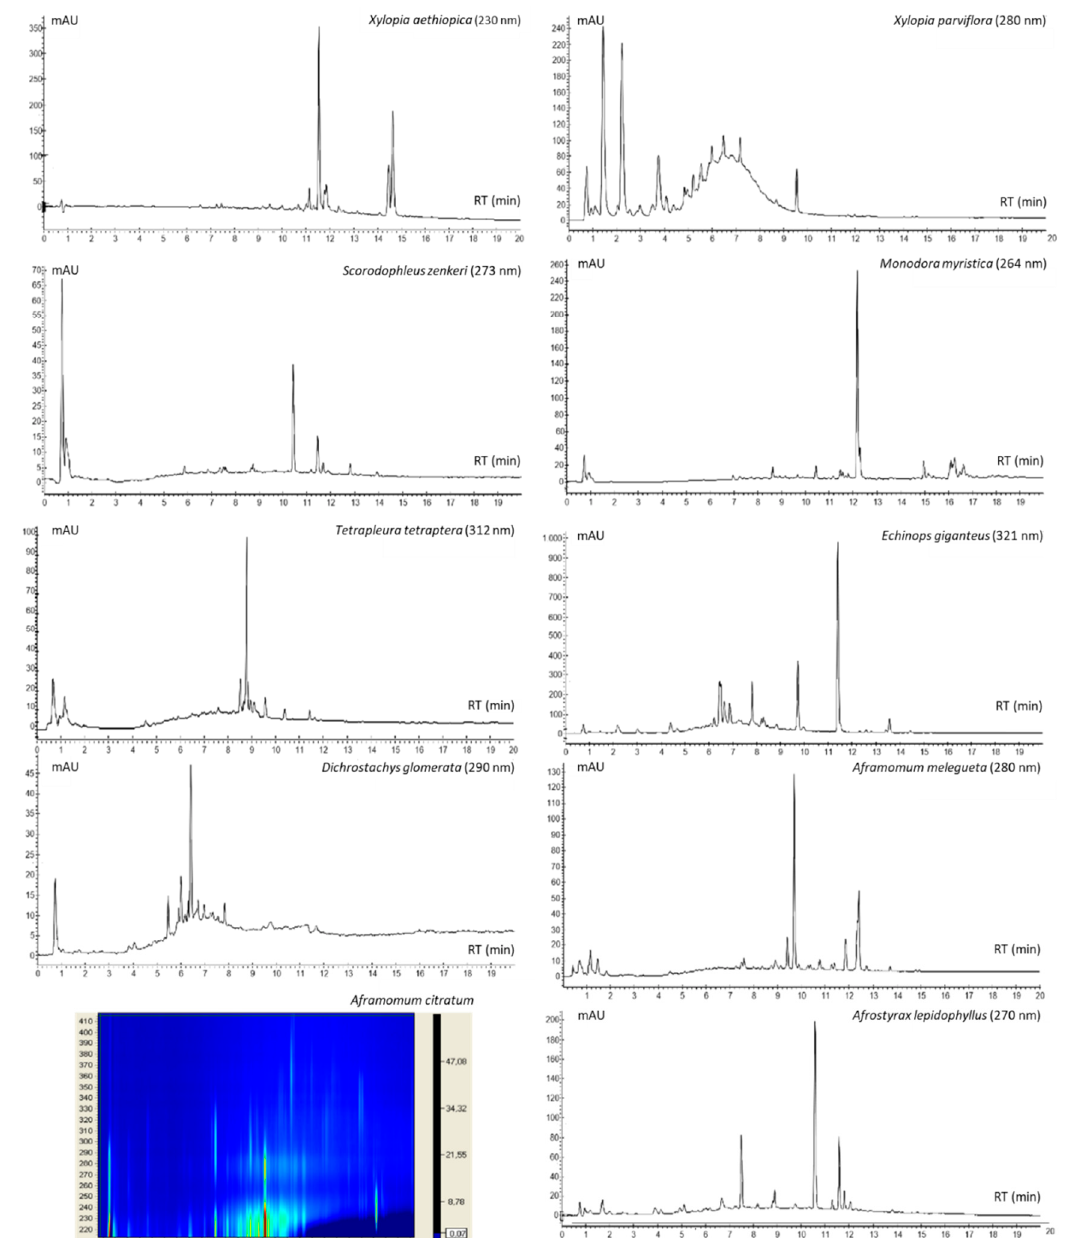
Figure 5. Reverse-phase high-performance liquid chromatography coupled to a diode array detector (HPLC-UV-DAD) analysis of spice extracts. Chromatogram of the components of Xylopia aethiopica , Xylopia parviflora , Scorodophloeus zenkeri , Monodora myristica , Tetrapleura tetraptera , Echinops giganteus , Dichrostachys glomerata , Aframomum melegueta , Afromomum citratum , and Afrostyrax lepidophyllusii extracts.